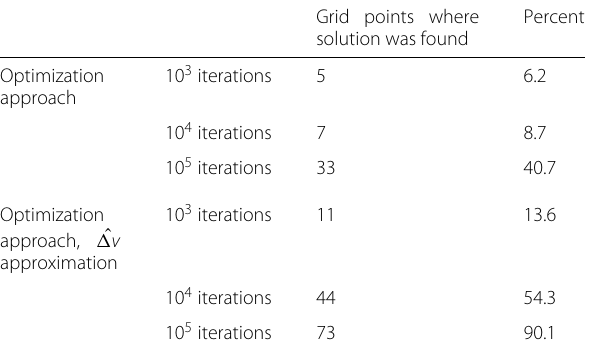
Optimization approach, ˆ (cid:12) v approximation